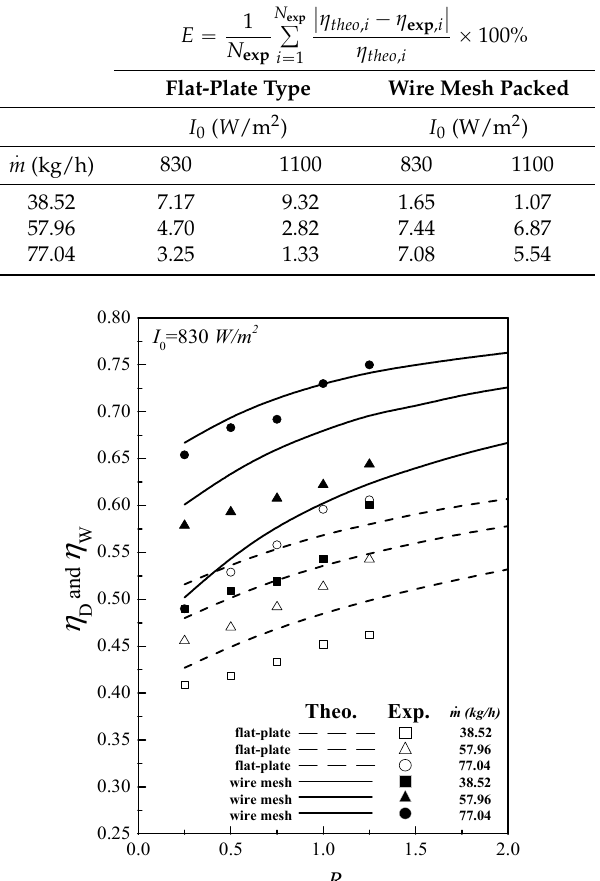
Figure 4. Effects of recycle ratio and air mass flow rate on collector efficiencies ( I 0 = 830 W/m 2 ).